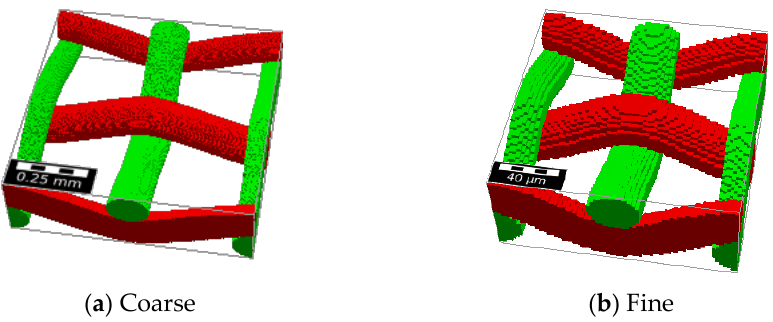
Figure 2. Computer model of a sample of the ( a )coarse and ( b )fine screens created by GeoDict [52].